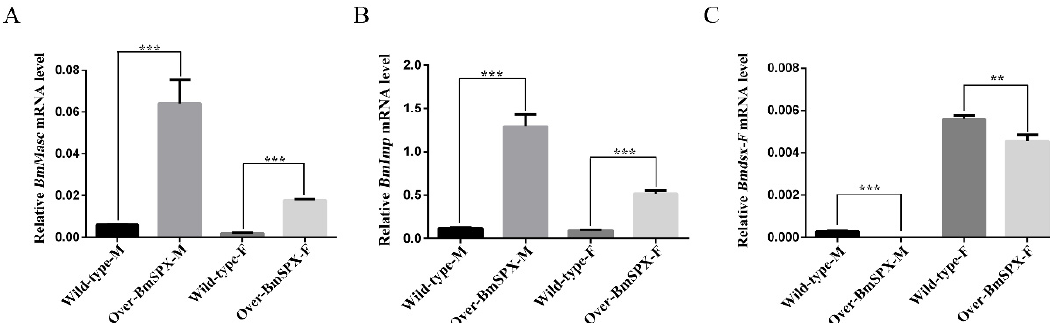
Figure 2. Expression levels of key factors in sex determination of Over-BmSPX transgenic strains. A value of p < 0.05 was considered to be statistically significant (* p < 0.05, ** p < 0.01, *** p < 0.001). ( A ) BmMasc expression level in Over-BmSPX transgenic strains. ( B ) BmImp expression level in Over-BmSPX transgenic strains. ( C ) Expression level of female-specific splicing of Bmdsx